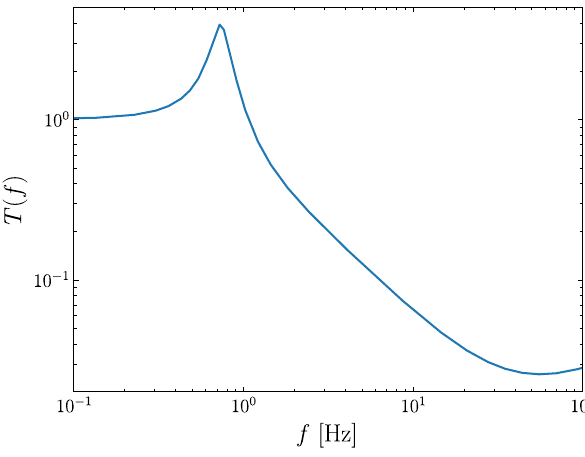
FIG. 13. Transfer function T ð f Þ vs frequency f for the quadru- pole stabilization system